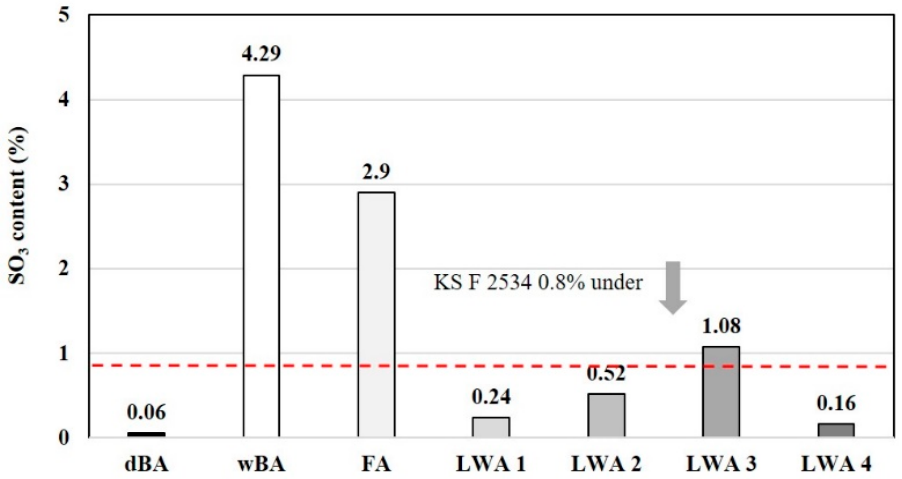
Figure 10. SO 3 contents of the test materials.